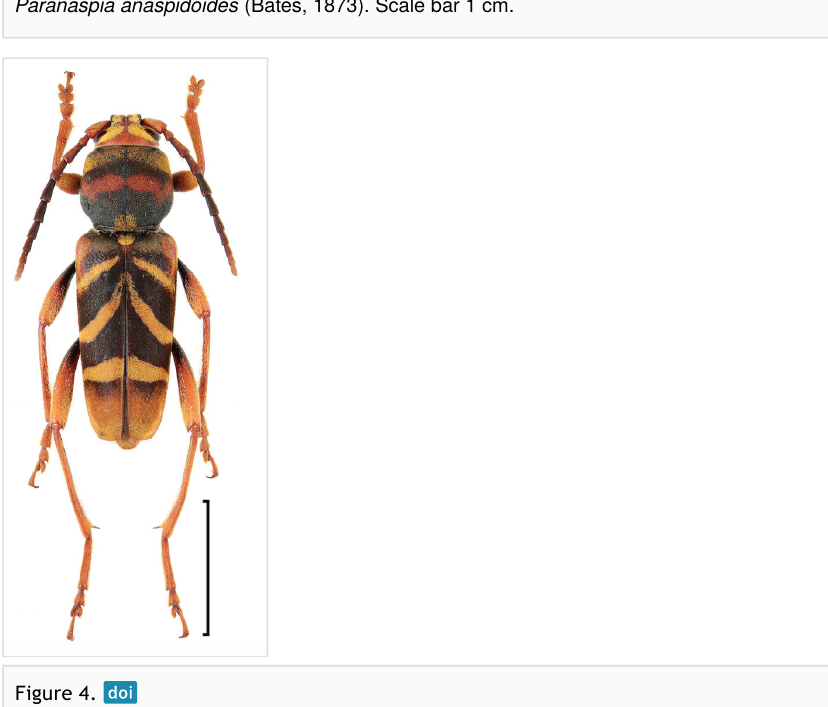
Figure 3. Paranaspia anaspidoides (Bates, 1873). Scale bar 1 cm.